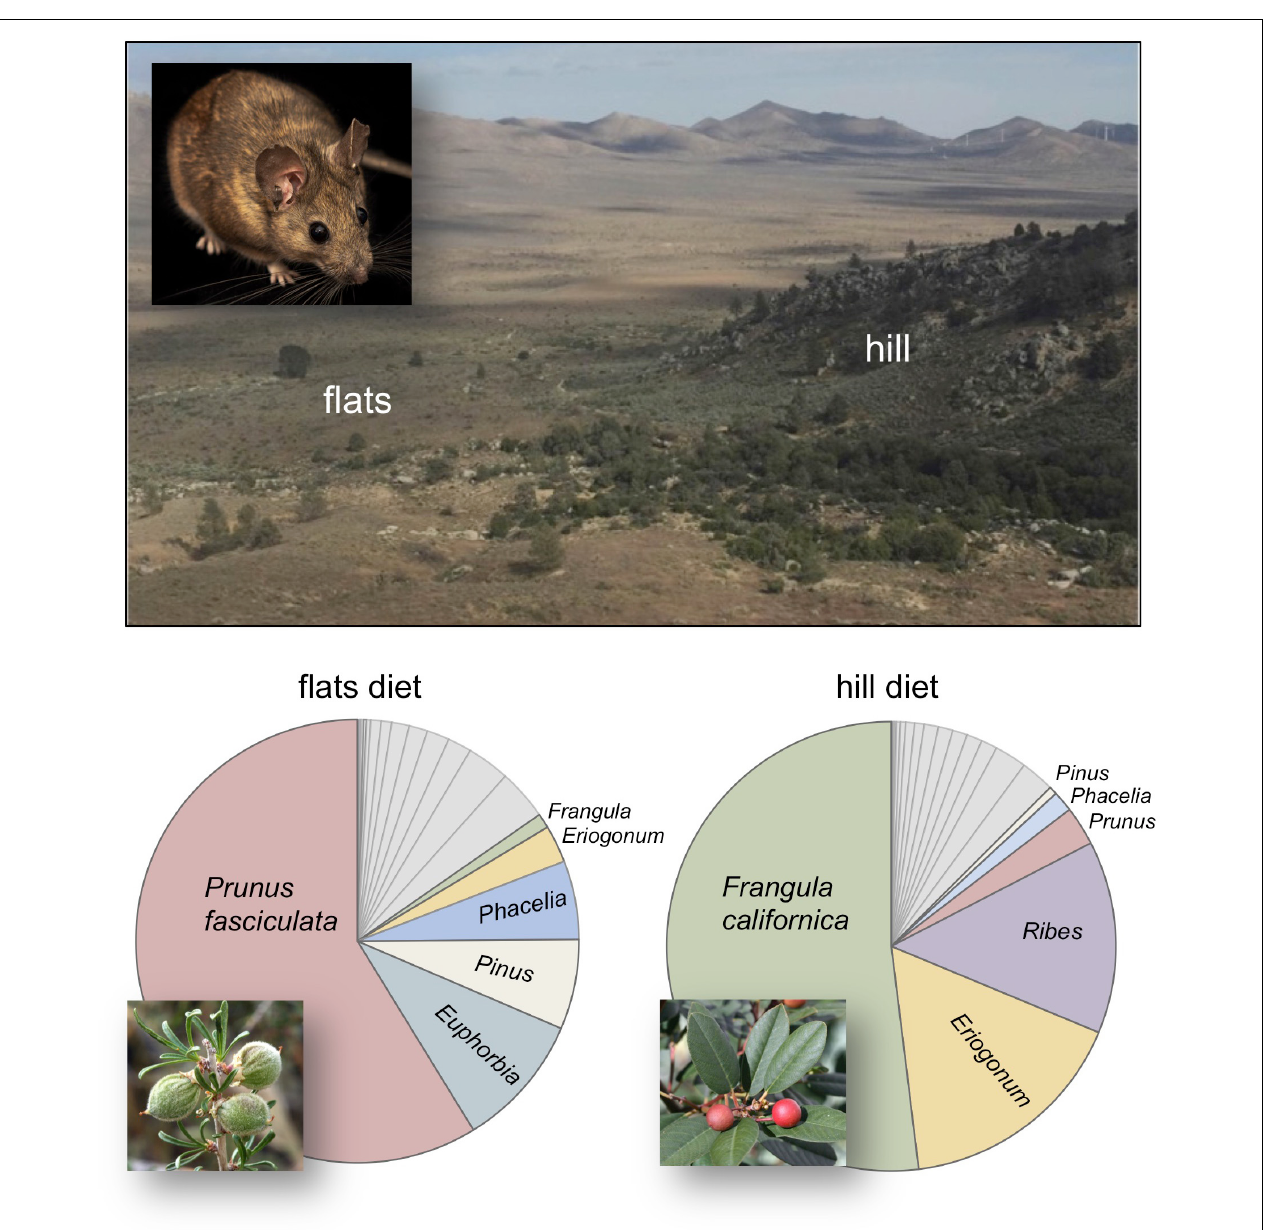
FIGURE 1 | Diet composition of woodrats occupying the “flats” and “hill” habitats of a sharp ecological transition that exists at the Whitney Well site of Kelso Valley, California. The flats habitat is predominantly occupied by N. lepida while the hill is largely occupied by N. bryanti . Diet is represented as the relative read abundance of plant DNA found in fecal samples collected at woodrat nests in each habitat (N hill = 13, N flats = 12). A list of all plants, the range of relative read abundance values, and frequency of occurrence in each habitat are provided in Supplementary Table 1 . Inset shows Neotoma lepida , the desert woodrat (photo by Alexx Hamblin). Plant inset photos taken from CalPhotos; Prunus © 2008 Steve Matson, Frangula © 2008 John J.